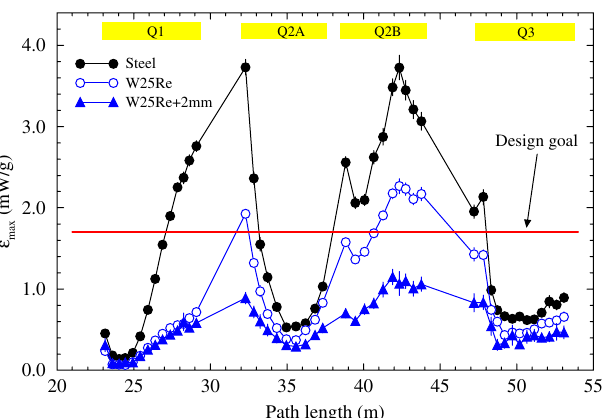
FIG. 10. (Color) The peak power density in the inner coil of the 100-mm Nb Sn quadrupoles calculated for the baseline thick- 3 ness of stainless steel, W25 Re liners, and for a W25 Re liner of increased thickness. W25 Re is used to replace both the steel liner and 1.5-mm steel cold bore adjacent to the liner (see Fig. 2).